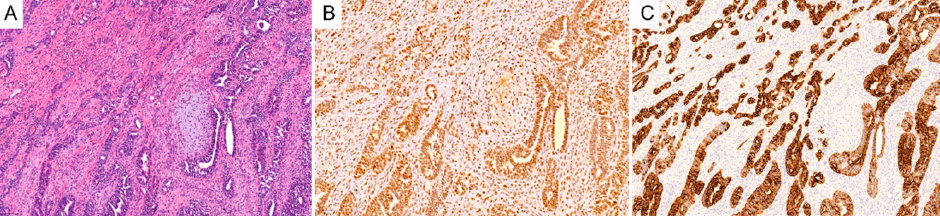
Figure 1. Representative hematoxylin and eosin section of a uterine carcinosarcoma ( A ) and im- munohistochemical expression of P53 ( B ) and cytokeratin-7 ( C ) with a serous epithelial component.